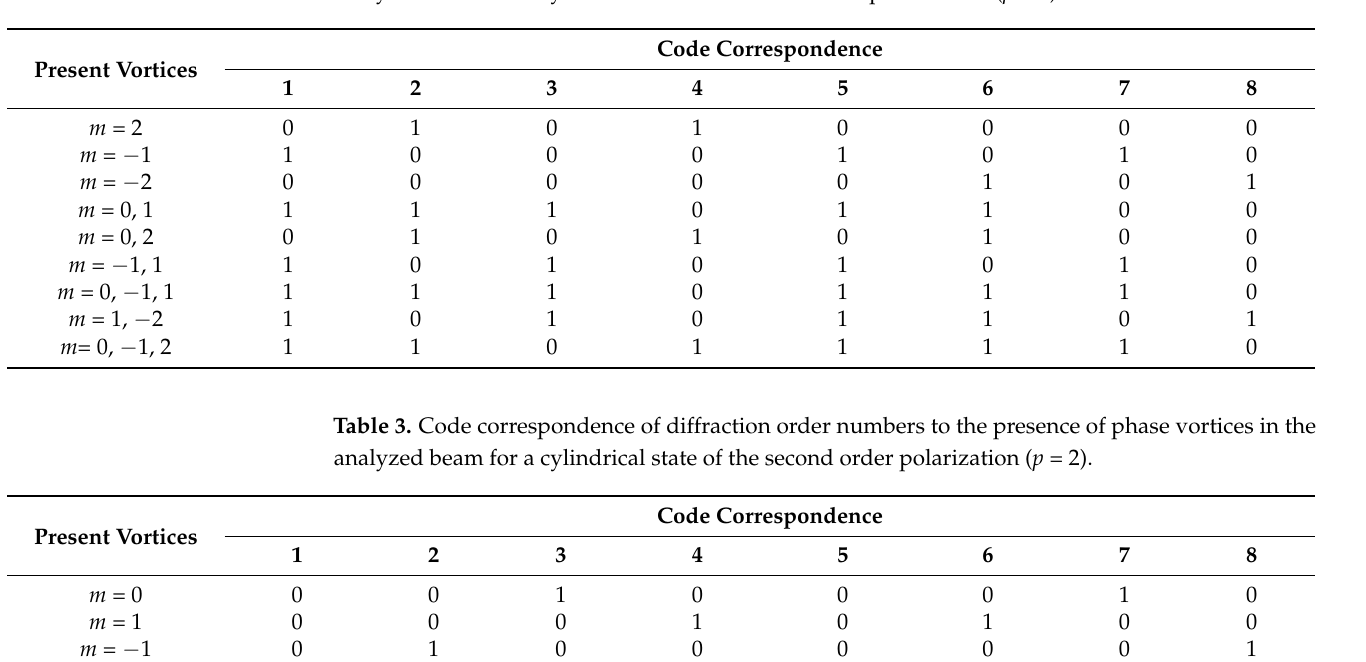
Table 2. Code correspondence of diffraction order numbers to the presence of phase vortices in the analyzed beam for a cylindrical state of the first order polarization ( p = 1).